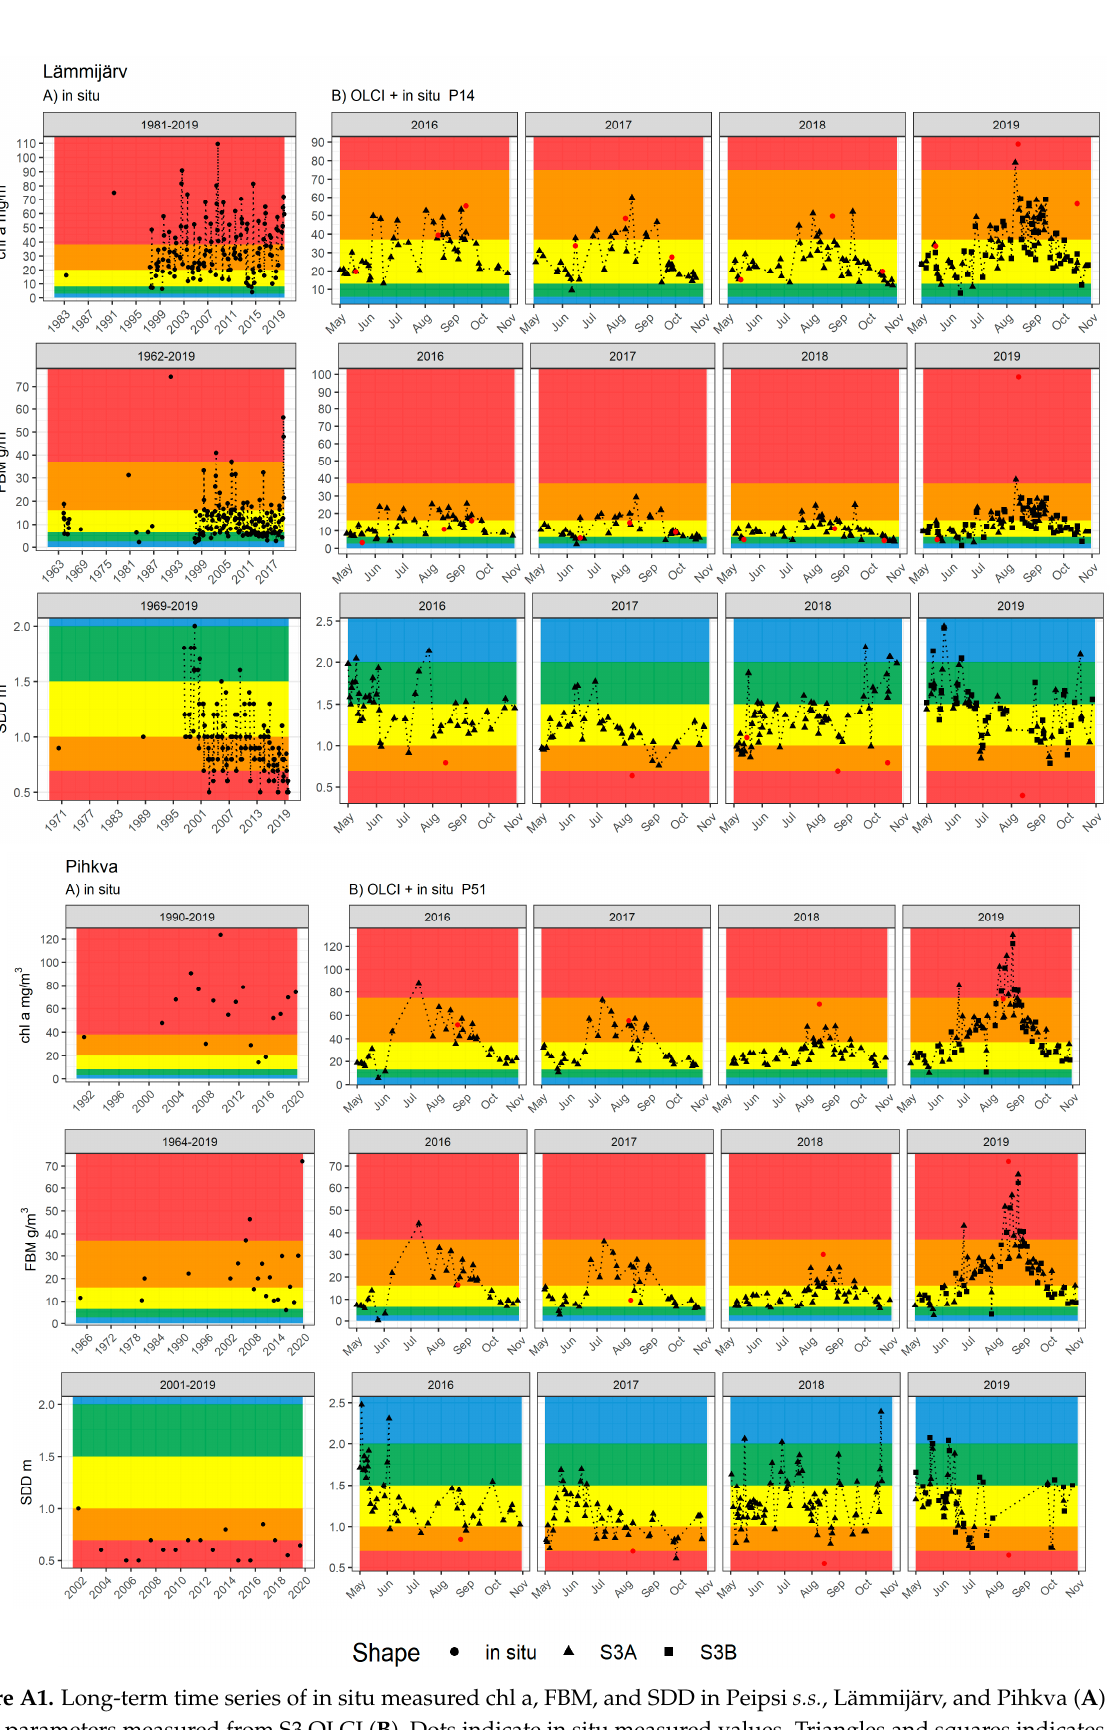
Figure A1. Long-term time series of in situ measured chl a, FBM, and SDD in Peipsi s.s. , Lämmijärv, and Pihkva ( A ) and same parameters measured from S3 OLCI ( B ). Dots indicate in situ measured values. Triangles and squares indicates S3A and S3B values, respectively. Different colors represent ecological status classes according to EU WFD.